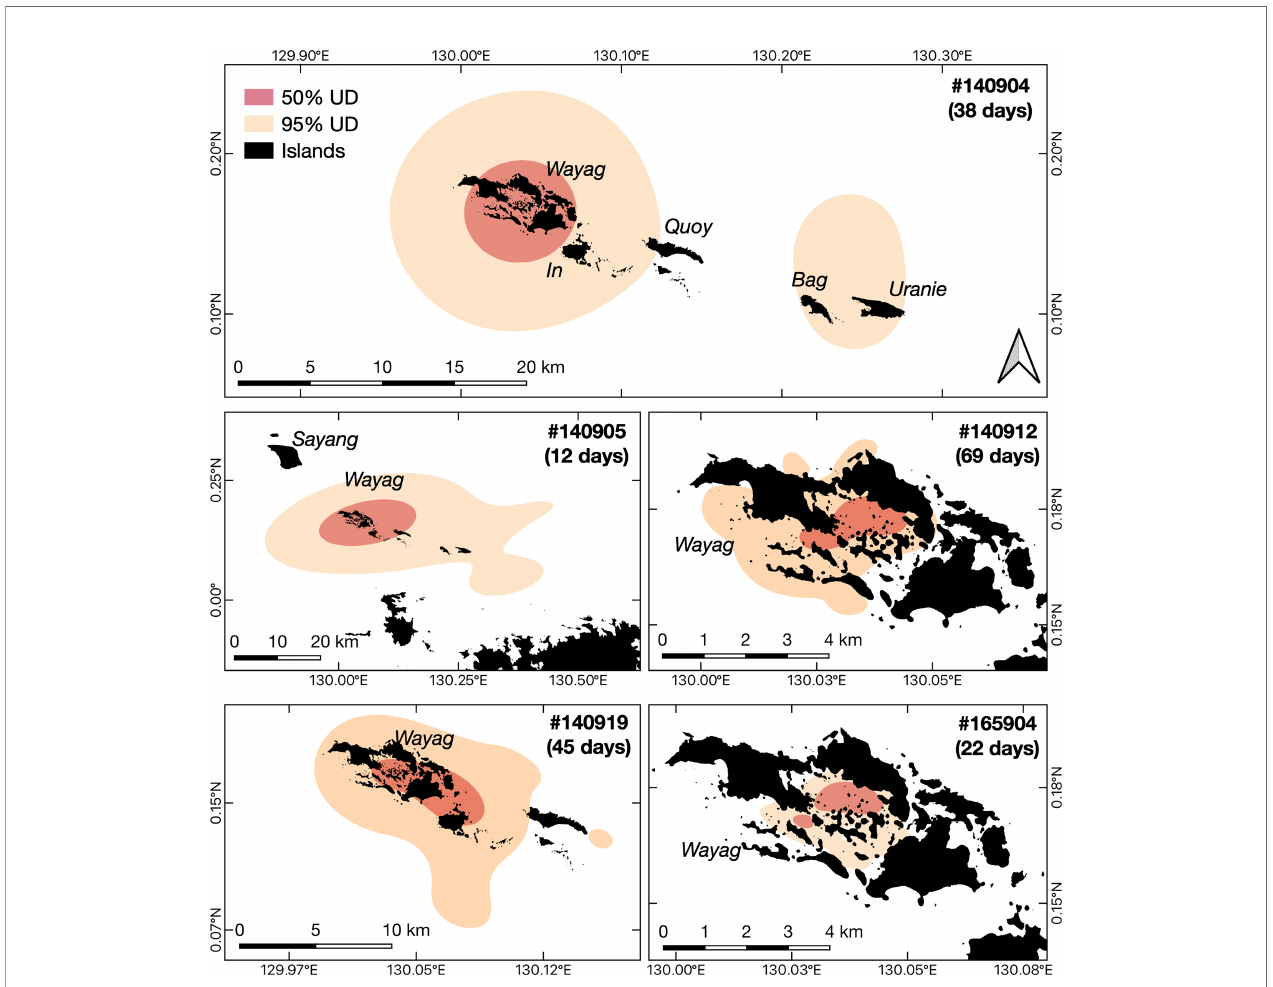
FIGURE 4 | Core activity space and the extent of activity space for each of the fi ve juvenile M. alfredi satellite tracked around Wayag, Raja Ampat. The red polygons (50% UD) and the orange polygons (95% UD) denote the smallest estimated core activity space and the extent of activity space, respectively, where the tagged juveniles were expected to spend their time during the tracking